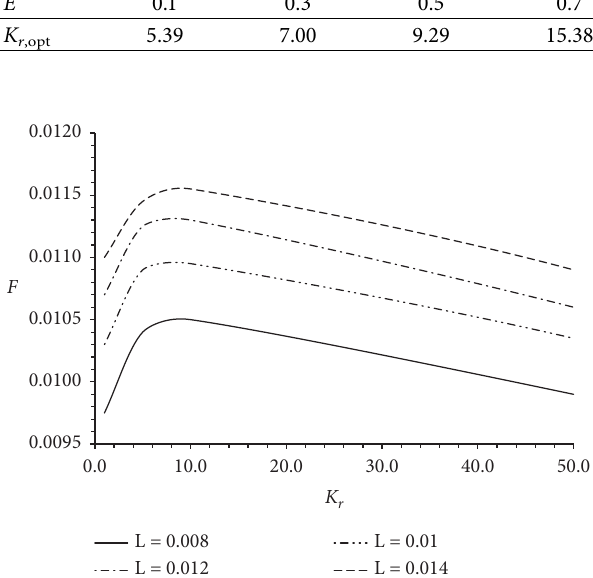
Figure 7: F vs K r at different channel heights for case O for radius ratio χ 2 � 0.3, E � 0.5, δ o � 0.2, δ i � 0.1.